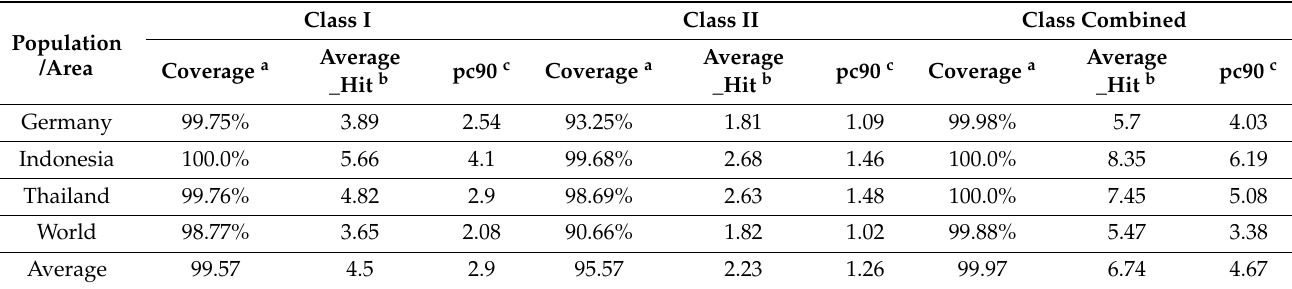
Table 9. Population coverage of the 12 chosen epitopes. A projected population coverage, average number of epitope hits/HLA combinations recognized by the population, and minimum number of epitope hits/HLA combinations recognized by 90% of the